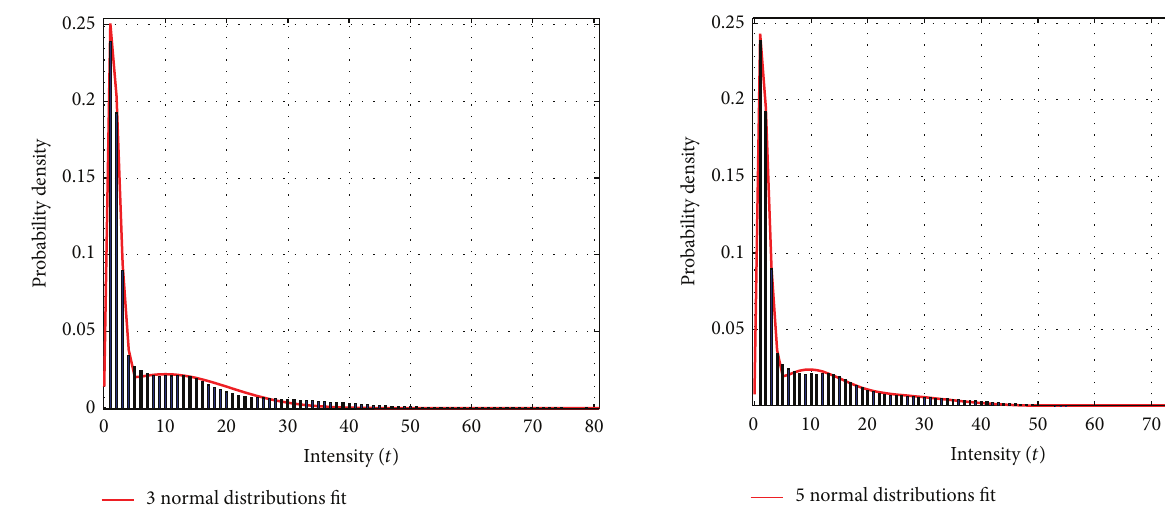
Figure 7: Three normal distributions fitted.